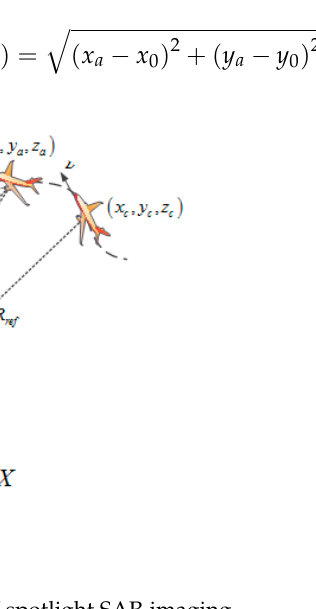
Figure 1. The geometry model of spotlight SAR imaging.